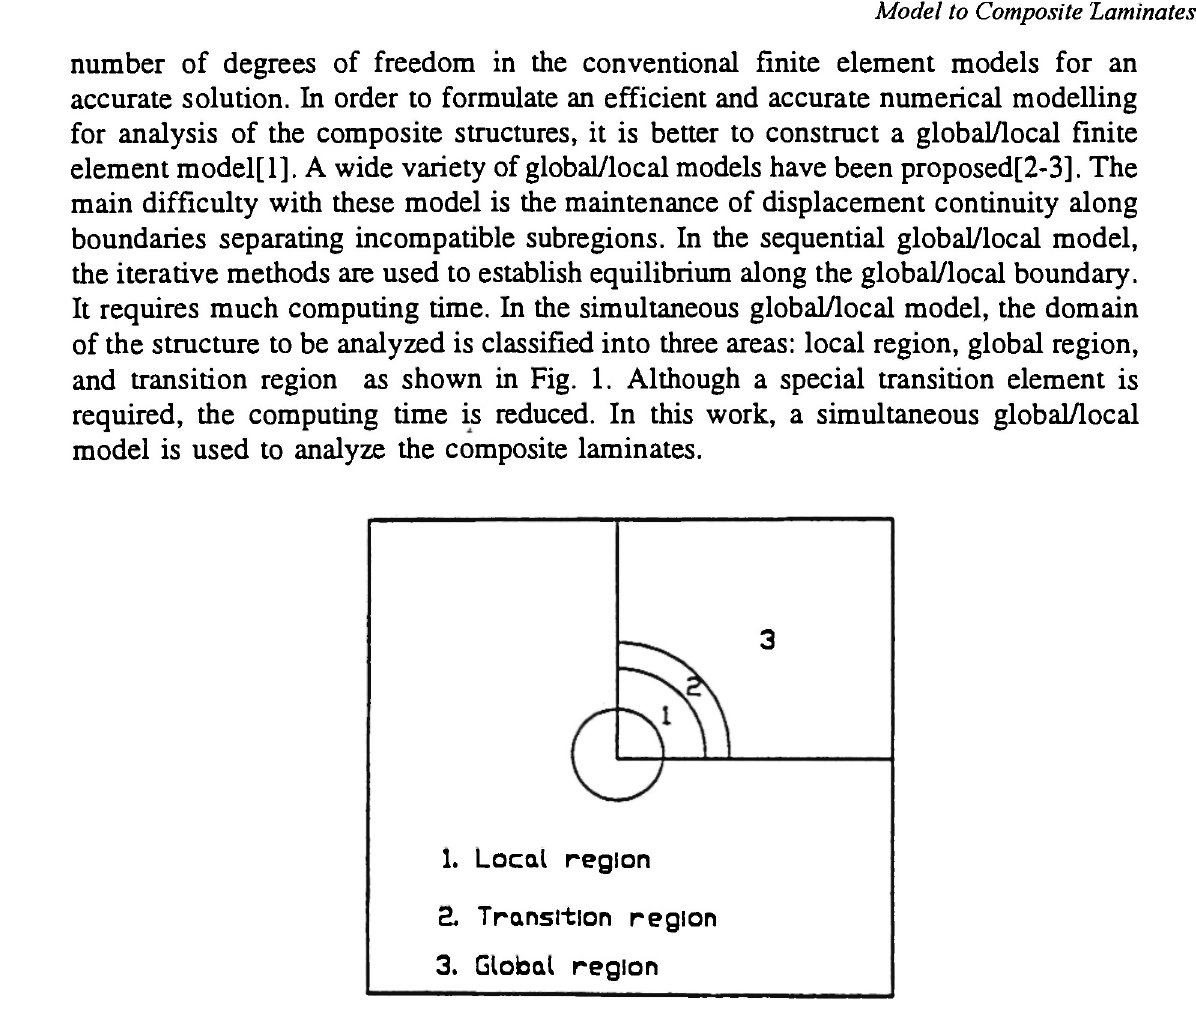
Figure 1 Global/Local Finite Element